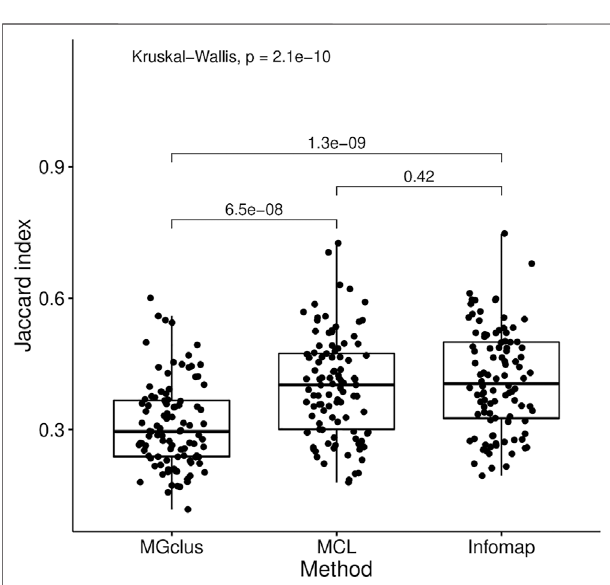
FIGURE3| AbilityoftheclusteringmethodsInfomap,MCL,andMGclus to recover original KEGG pathways in multi-pathway gene sets. Three pathwaysweregroupedintoasinglegenesetpriortoclustering.Eachmodule was assigned to the pathway with the greatest overlap, and the Jaccard indexoftheoverlapbetweentrueandassignedpathwayswascomputed.The Jaccard index distributions of the clustering methods were compared using Kruskal-Wallis and Wilcoxon